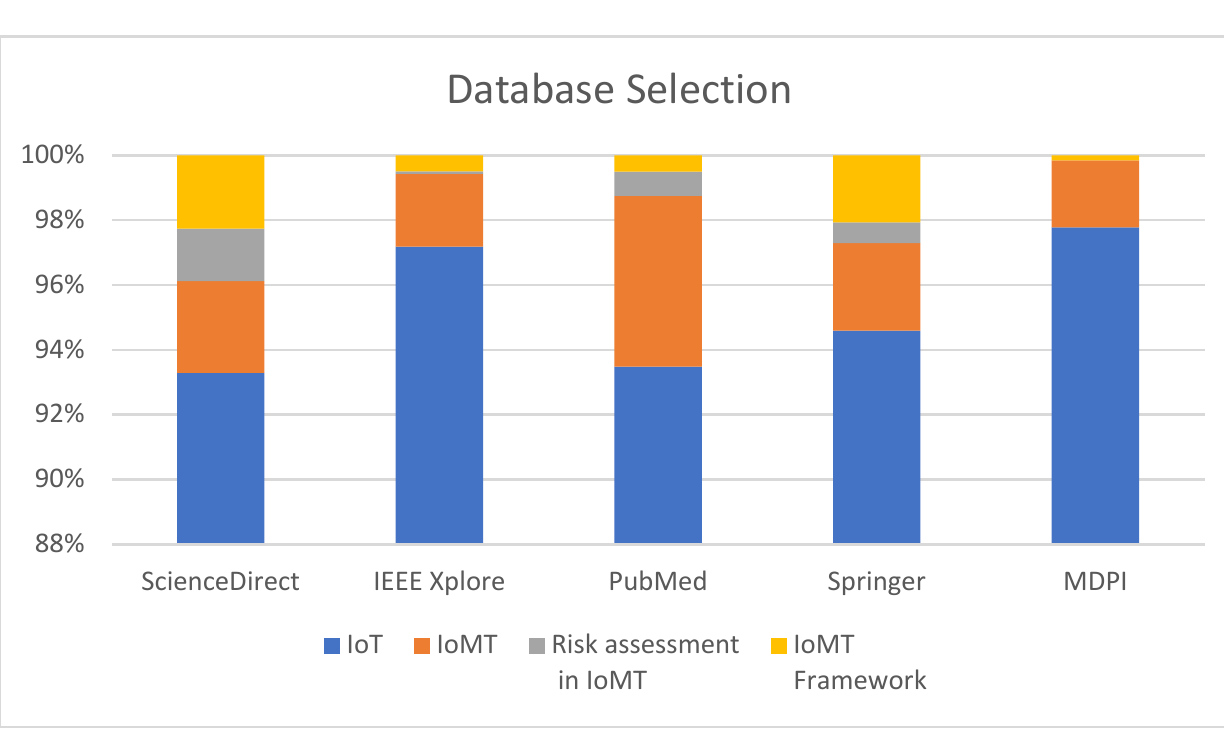
Figure 7. Database search selection.